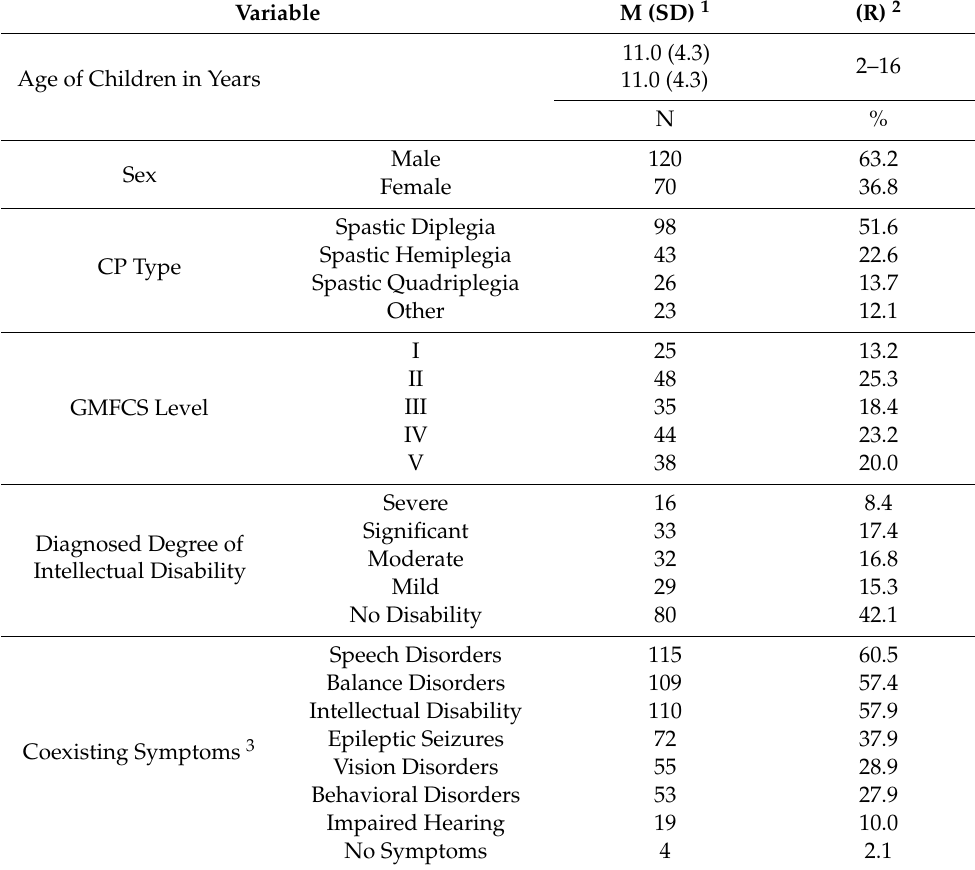
Table 3. Characteristics of the children in the study